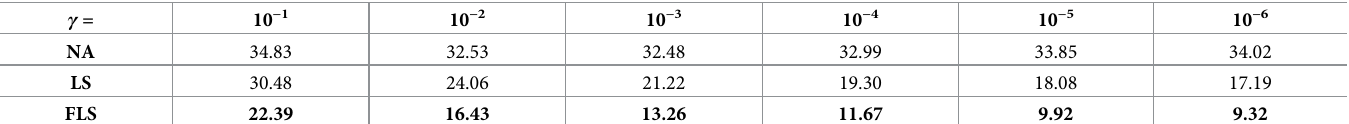
Table 2. Average running times of various p-value.